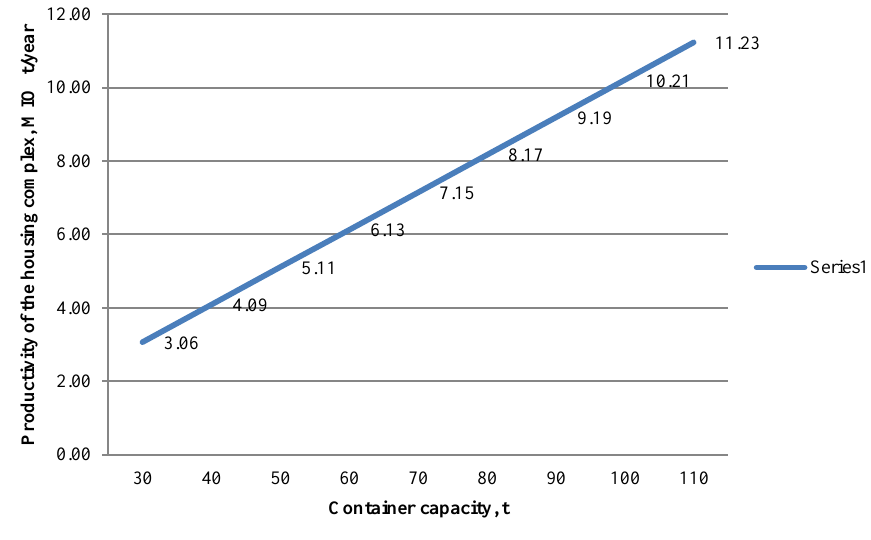
Fig. 2. Impact of the container capacity on the productivity of the hoisting